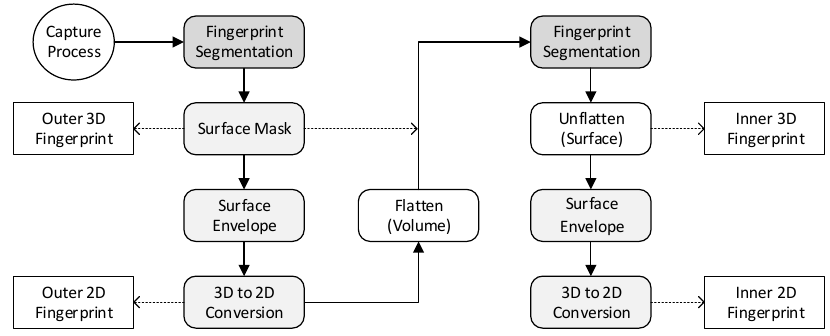
Figure 4. Complete signal processing